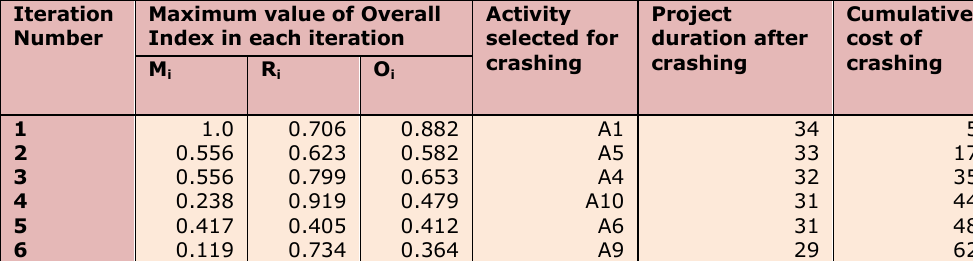
Table 3. Generation of One Solution for w =